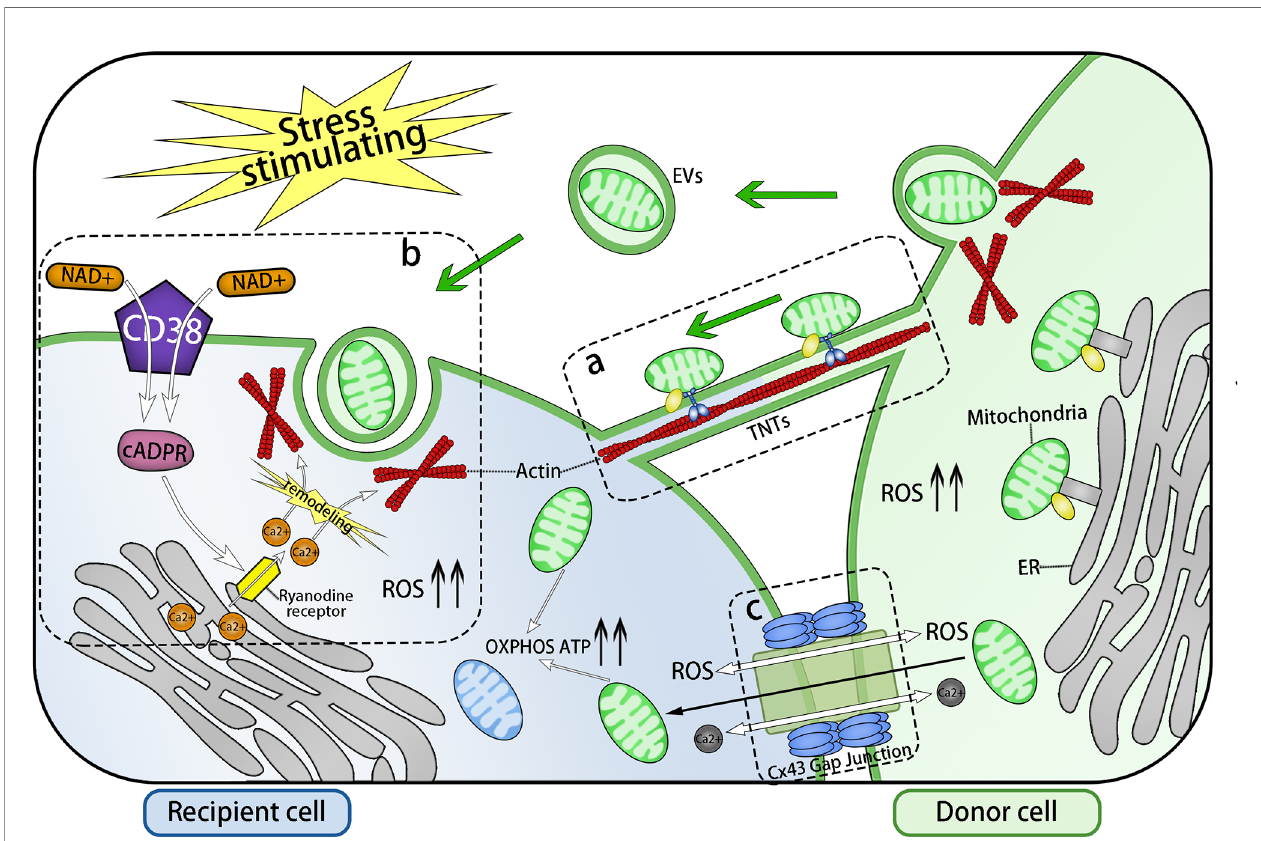
FIGURE 1 | Three Main Forms of Intercellular Communication Related to Transcellular Transfer of Mitochondria. Under the stimulation of energy stress, in fl ammatory stimulation, or DNA damage, intracellular ROS levels increase and three forms of intercellular communication related to mitochondrial transcellular transfer are formed: TNTs, EVs, and GJs. (A) TNTs connects the cytoplasm of two cells, whose main framework is F-actin. Mitochondria are anchored to the actin skeleton by speci fi c transport complex and driven by them to move from one cell to another via TNTS. (B) EV endocytosis is mediated by the NAD+/CD38/cADPR/Ca2+ pathway: Intracellular NAD+ increases and transfers to the extracellular environment under stress conditions. Then, NAD+ is catalyzed by activated transmembrane protein CD38 to generate cADPR, a second messenger controlling the release of the intracellular Ca 2+ pool. cADPR acts on Ryanodine receptors (RyRs) on the endoplasmic reticulum, which leads to an increase in the intracellular Ca 2+ concentration, following the remodeling of the actin cytoskeleton and invagination of cell membrane, thereby completing the endocytosis of EVs. The release of EVs and the formation of TNTs might also be mediated by this pathway. Through transcellular transfer of mitochondria, based on the actin cytoskeleton, the OXPHOS, the ATP level, and the viability of the recipient cells are all improved. (C) Cx43 gap junction channel (GJCs) also take part in the transcellular transfer of mitochondria. There are three possible pathways: Ca2+ or ROS exchange via Cx43 GJCs to modulate the formation of channels transferring mitochondria, or the direct transfer of mitochondria. ERMES: a complex that anchors mitochondria to endoplasmic